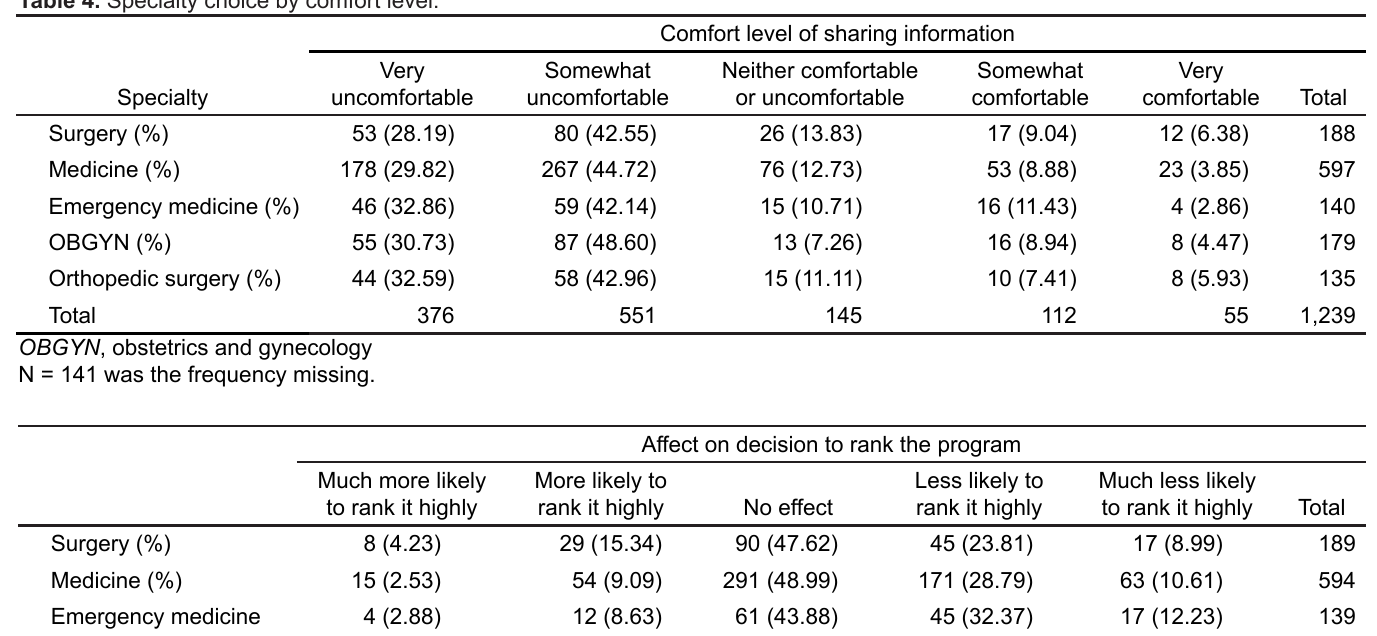
Table 4. Specialty choice by comfort level.